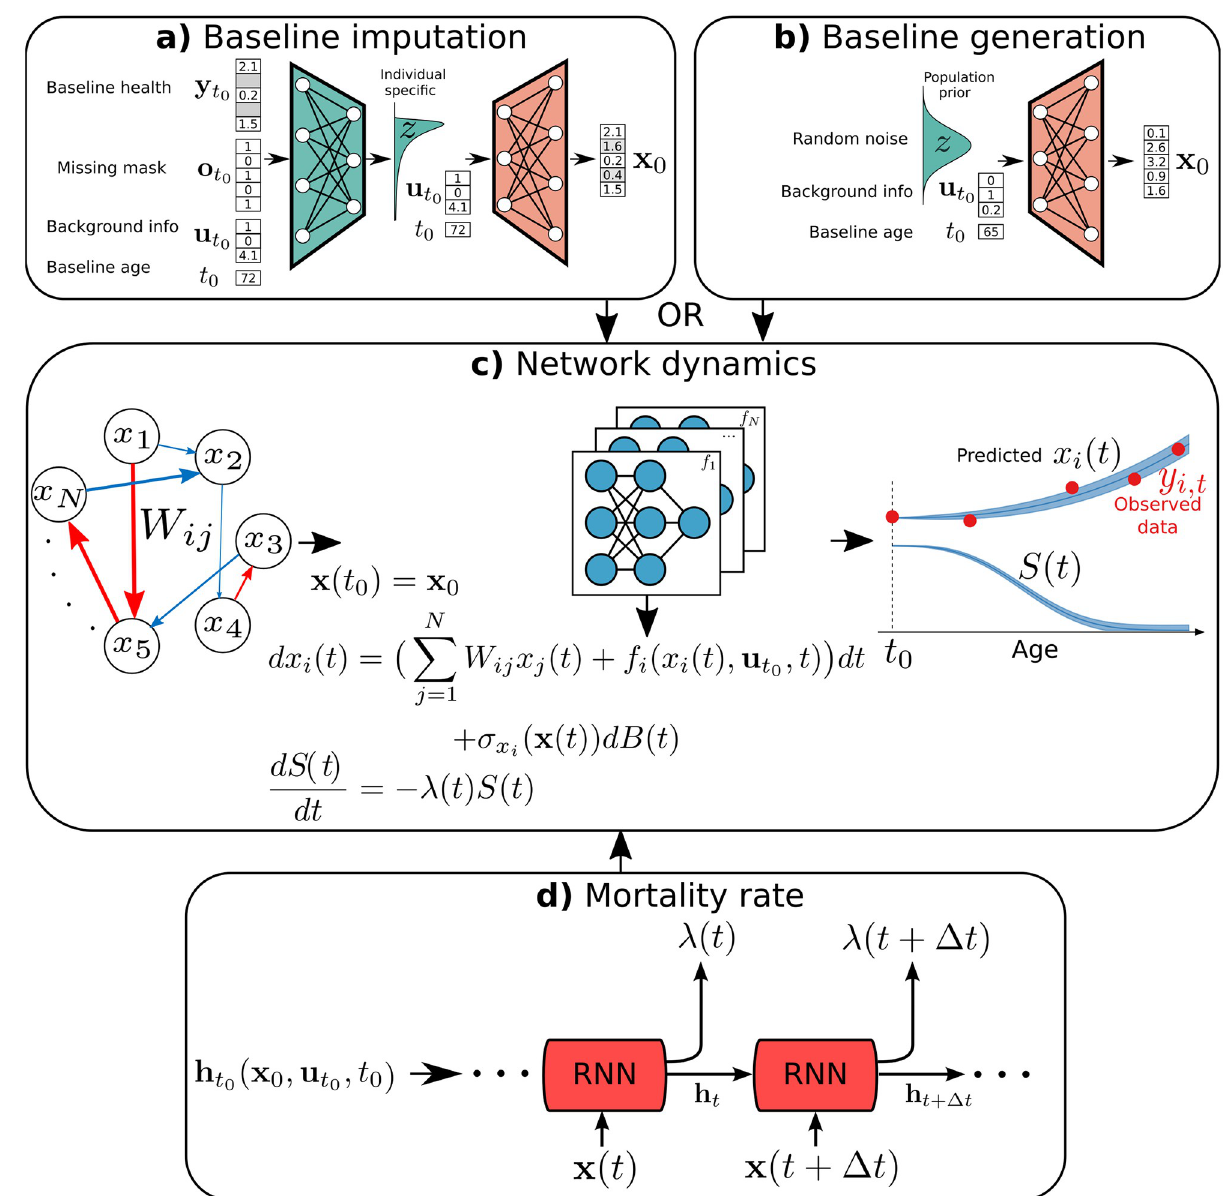
Fig 1. DJIN model of aging. a) Baseline imputation is performed using the baseline health measurement y , missing mask o , background health t 0 t 0 information u , and baseline age t 0 as input to an encoder neural network (green) that parameterizes a latent distribution. Sampling from this latent t 0 distribution and using a decoder neural network (orange) gives an imputed complete baseline health-state x 0 . b) Baseline generation conditional on background health information u , and baseline age t 0 can be used instead of imputation. The population latent distribution is sampled and used with t 0 the same decoder neural network (orange) to produce a synthetic baseline health state x 0 . c) Network dynamics stochastically evolve the health state x ( t ) in time starting from the baseline state x 0 . The stochastic dynamics are modeled with a stochastic differential equation which includes the pairwise network interactions with connection weight matrix W , general diagonal terms f ð x ð t Þ ; u ; t Þ parameterized as neural networks, and a diagonal i i t 0 ( x ) also parameterized with a neural network. d) The survival function evolves in time based on the state and history covariance matrix for the noise σ x of the health state x using a recurrent neural network (RNN). The initial state of the RNN, h , is set using the background health information u , t 0 t 0 baseline age t 0 , and x 0 . Details are provided in the Methods. The code for our model is available at